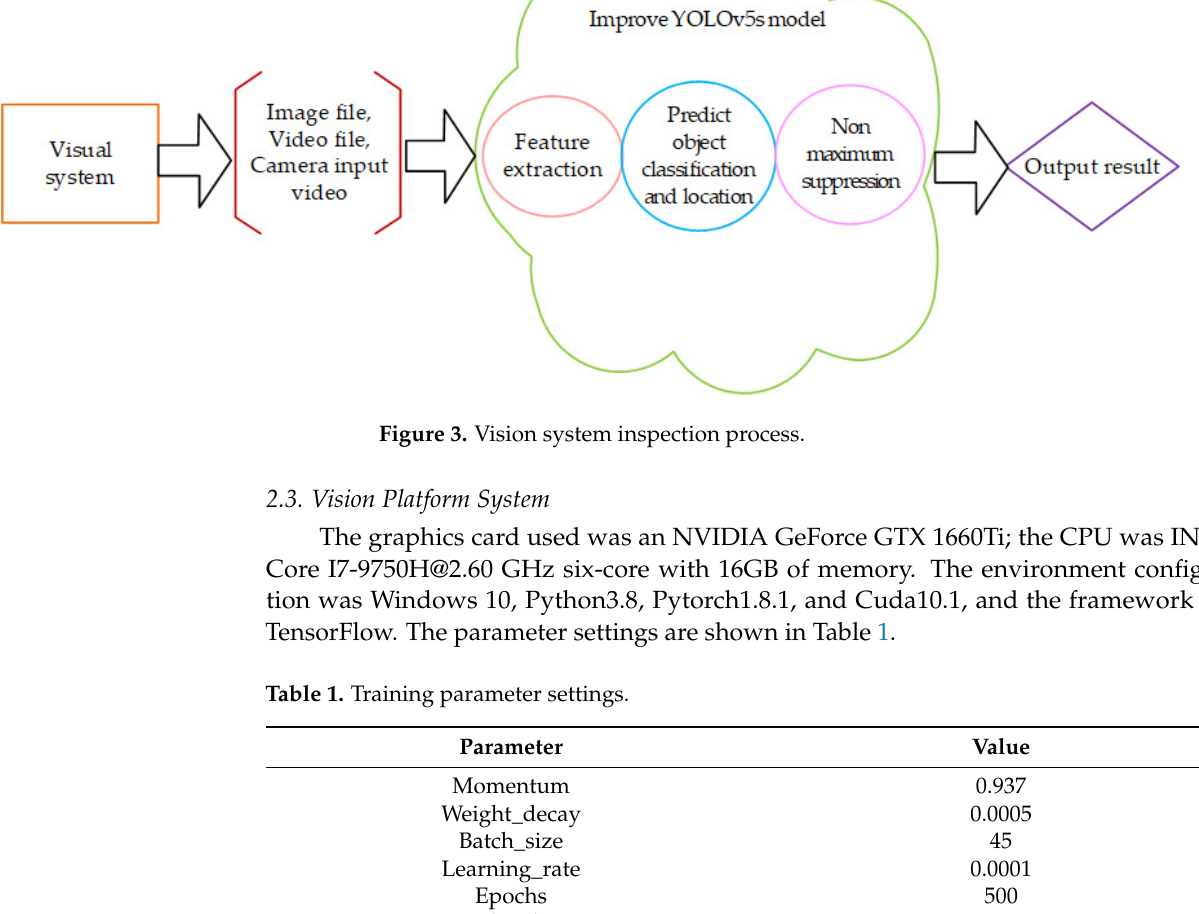
Figure 3. Vision system inspection process.